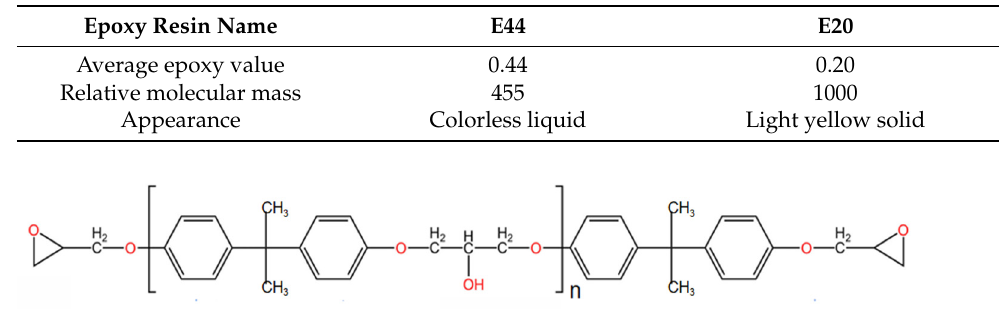
Table 1. Basic parameters of E44 and E20.